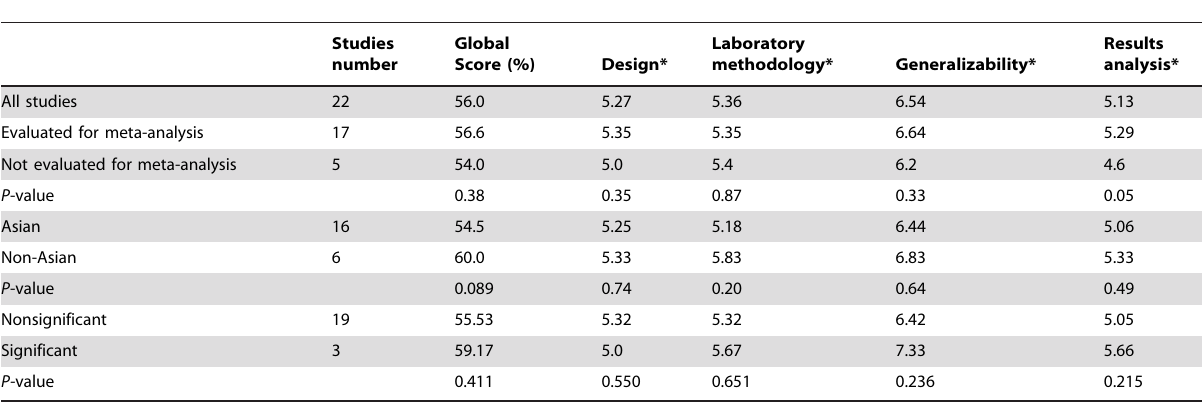
Table 2. Results of the methodological assessment by the European Lung Cancer Working Party